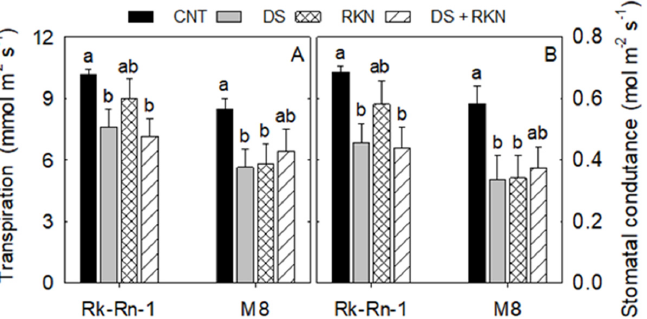
Figure 2. Drought and nematode treatments effects on ( A ) transpiration (mmol m − 2 s − 1 ); ( B ) stomatal conductance (mmol m − 2 s − 1 ) of cotton genotypes (Rk-Rn-1 and M8) measured under control (CNT), drought stress (DS), nematode stress (RKN), and DS + RKN combination in 2021. Vertical bars denote mean ± SE. Means followed by a common letter are not significantly different by Duncan’s multiple range test at the 5% level of significance.